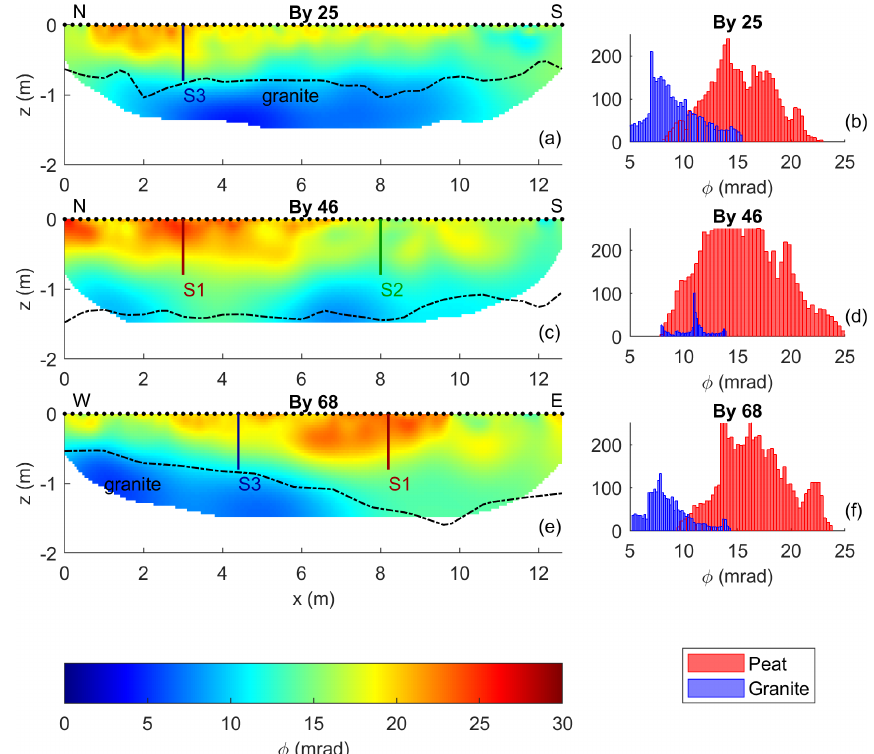
Figure 7. Imaging results for data collected along profiles By 25 (a) , By 46 (c) , and By 68 (e) , expressed as phase values φ of the complex conductivity. The dashed lines represent the contact between peat and granite; the black dots show the electrode positions at the surface. The vertical lines represent the location of the fluid (S1, S2, S3) and freeze-core (S1, S2) samples. The histograms represent the phase values of the granite and peat extracted from the imaging results in Fig. 6b, d, f according to the geometry of the dashed